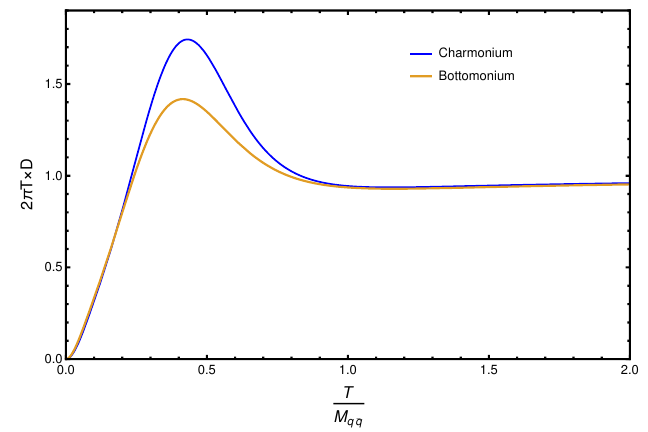
Figure 11 . Numerical results for the charge di(cid:11)usion coe(cid:14)cient of charmonium and bottomonium multiplied by 2 (cid:25)T as function of the temperature (rescaled by the mass of the (cid:12)rst hadronic